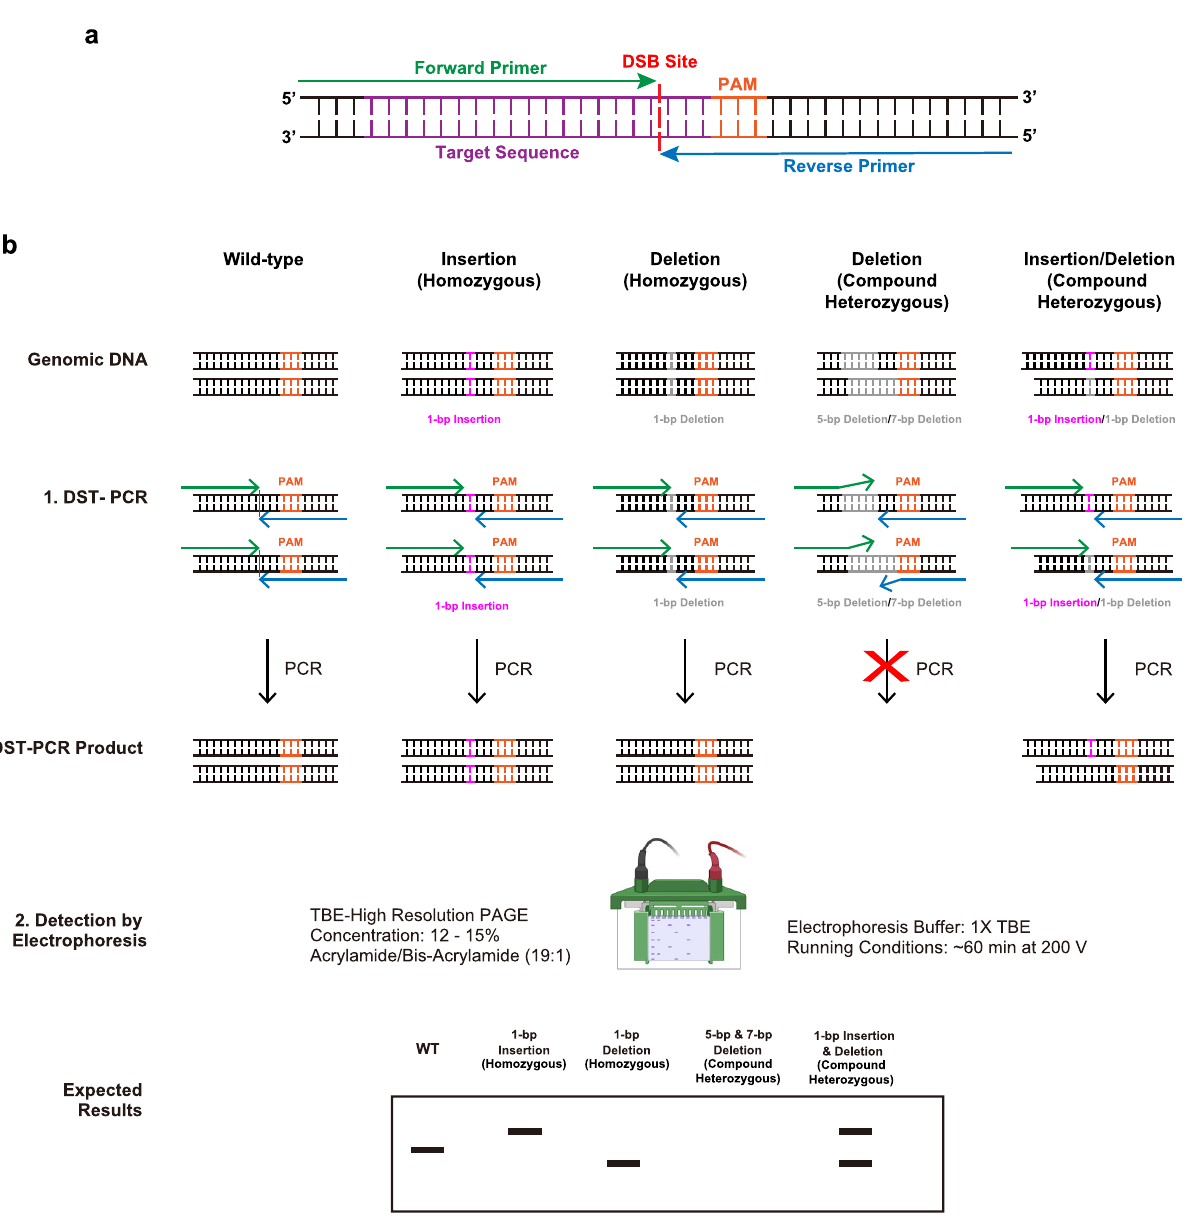
nucleotide A (− 8 to − 7 from position 0) in the other allele (Fig. 2g). Ift144 is a part of the IFT-A protein com- plex essential for anterograde transport in cilia and primary cilia formation 19,20 . The visibility of 1-bp resolution on high-resolution PAGE was also confirmed by running triplicates of the DST-PCR amplicons from clone #4 and wild-type control samples (Supplementary Fig. 1c). To confirm the loss of Ift144 protein in the KO cells, the primary cilium was visualized in clone #4 using an antibody against the primary cilium marker Arl13b. Compared to the wild-type cells, the clone #4 cells had no primary cilium (Fig. 2h), confirming the generation